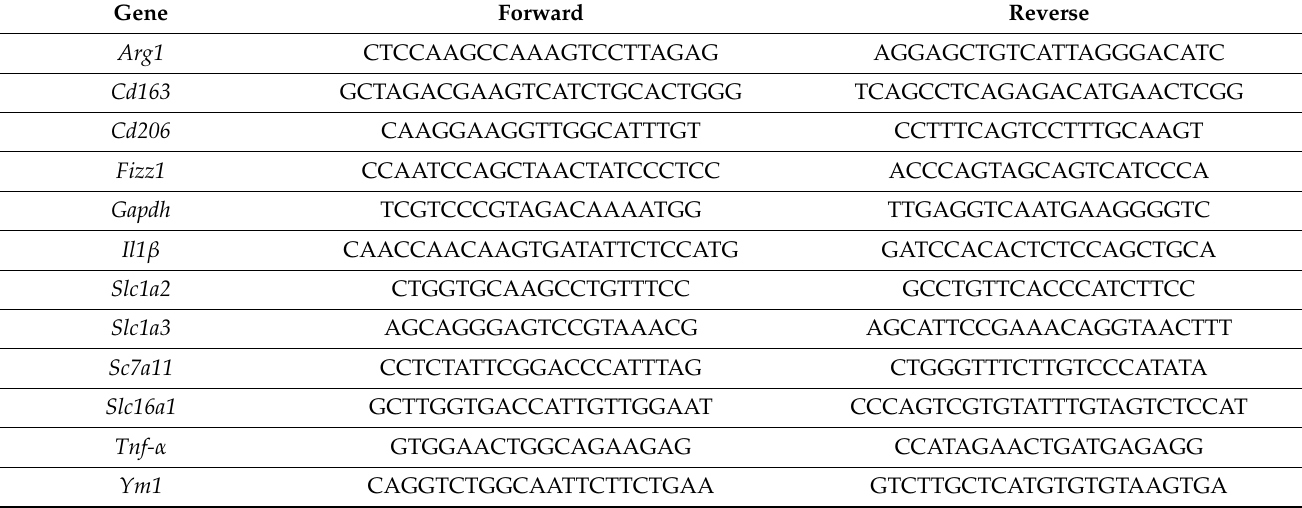
Table 1. Primer sequences. Forward and reverse primer sequences used for gene expression analysis by qPCR are listed.